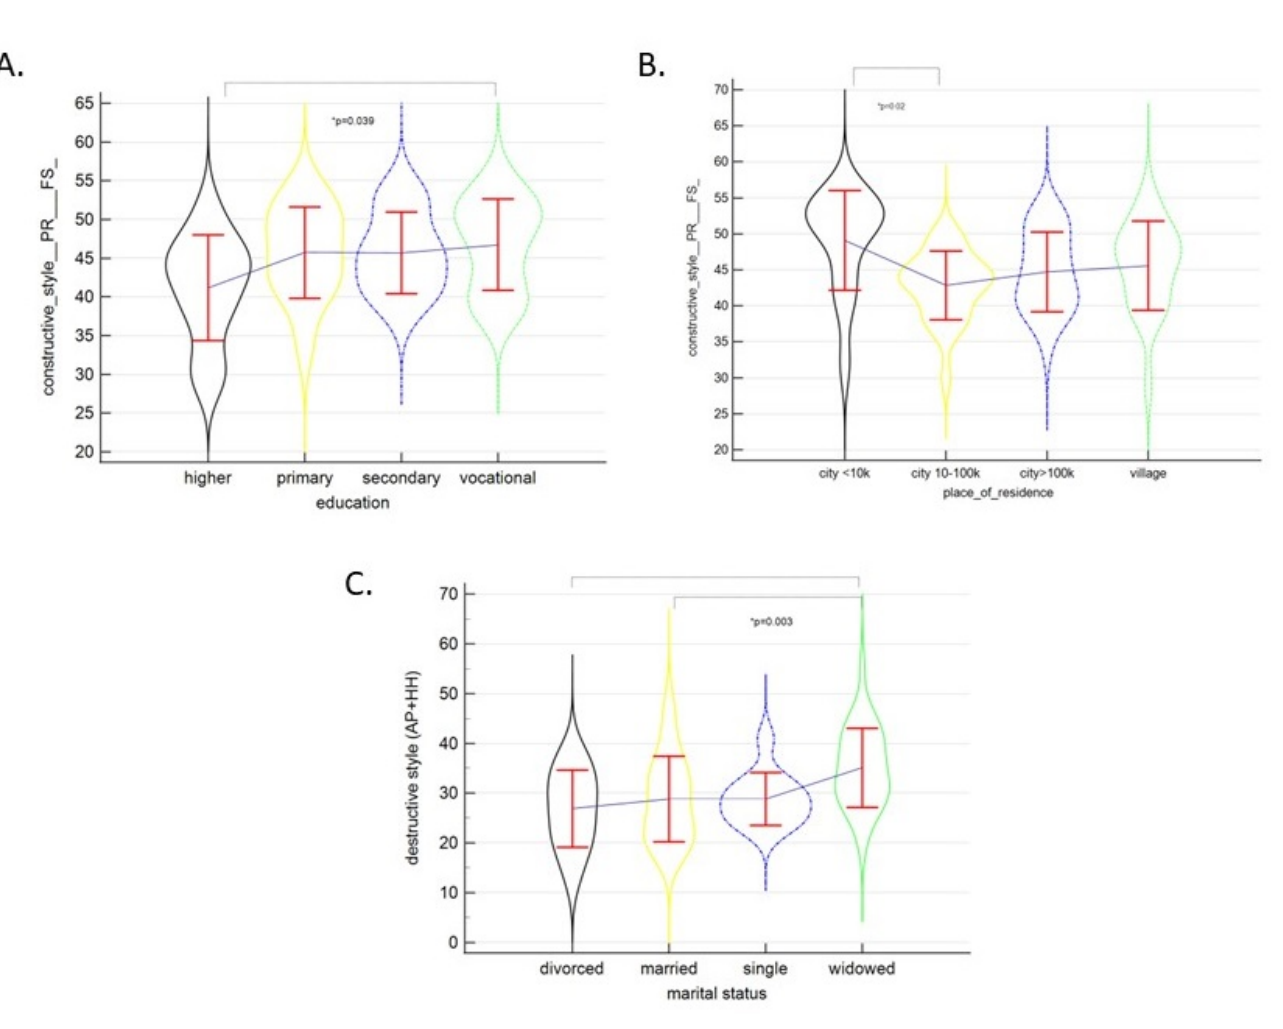
Figure 1. The constructive style by education ( A ) and place of residence ( B ), and destructive style by education ( C ). Means and standard deviations are given. * p < 0.05. Table 3. Correlation between age and the scores on the Mini-Mac subscales.